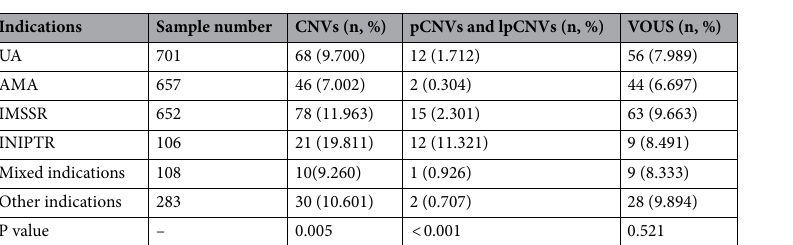
Figure 3. The distribution of CNVs on each chromosome. Schematic diagrams of the distribution of all CNVs ( A ), microdeletions ( B ), microduplications ( C ) and pCNVs ( D ) detected in our study. Blue areas represented that no CNVs were detected in that area. The more CNVs detected in an area, the area was redder.